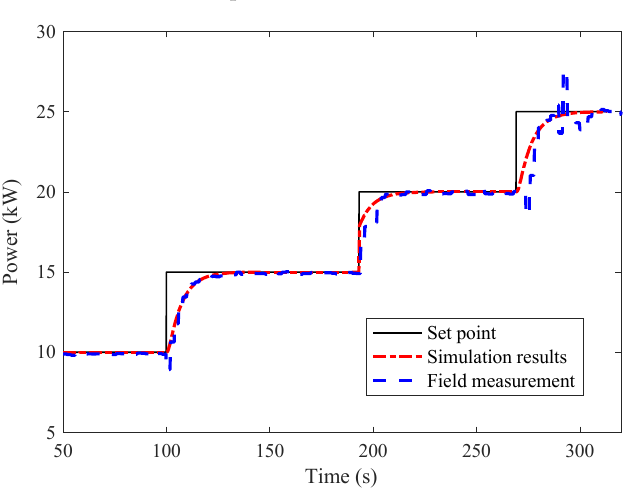
Figure 5. MT model acquisition.